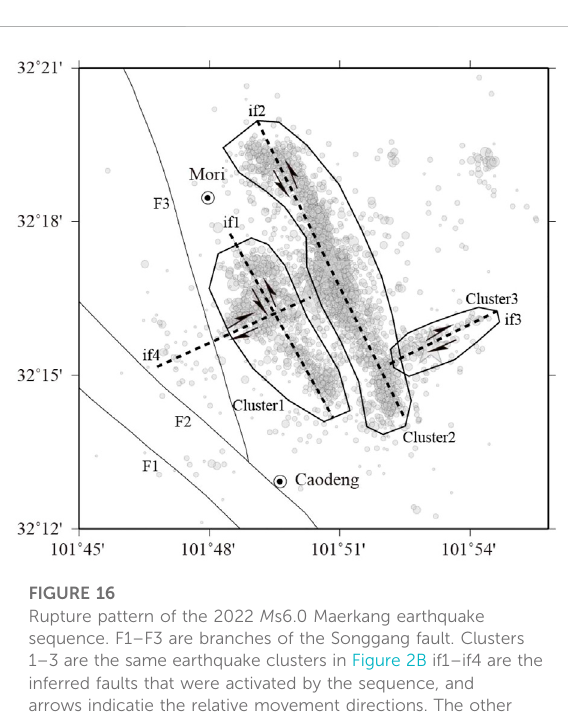
FIGURE 16 Rupture pattern of the 2022 M s6.0 Maerkang earthquake sequence. F1 – F3 are branches of the Songgang fault. Clusters 1 – 3 are the same earthquake clusters in Figure 2B if1 – if4 are the inferred faults that were activated by the sequence, and arrows indicatie the relative movement directions. The other symbols are the same as those in Figure